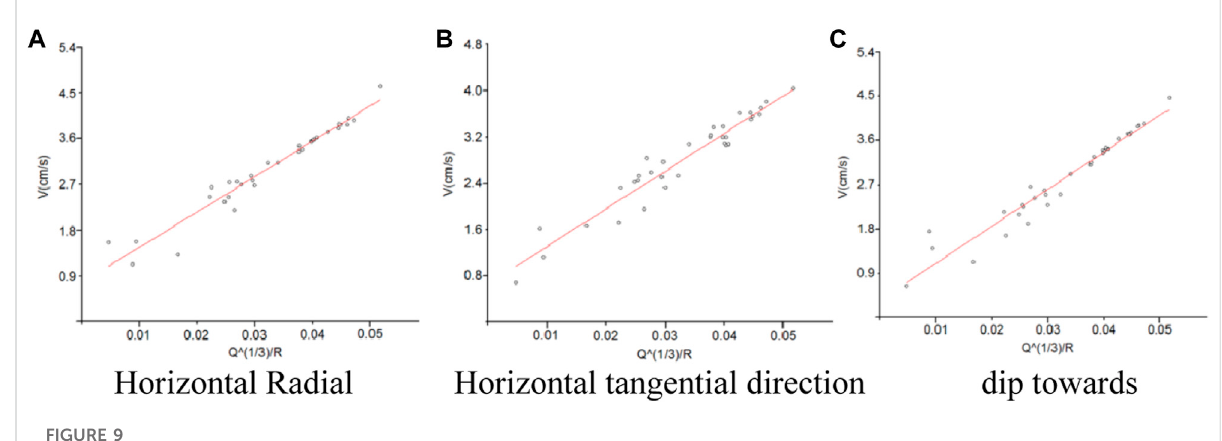
FIGURE 9 Regression curve of measured vibration speed of pre-cracking